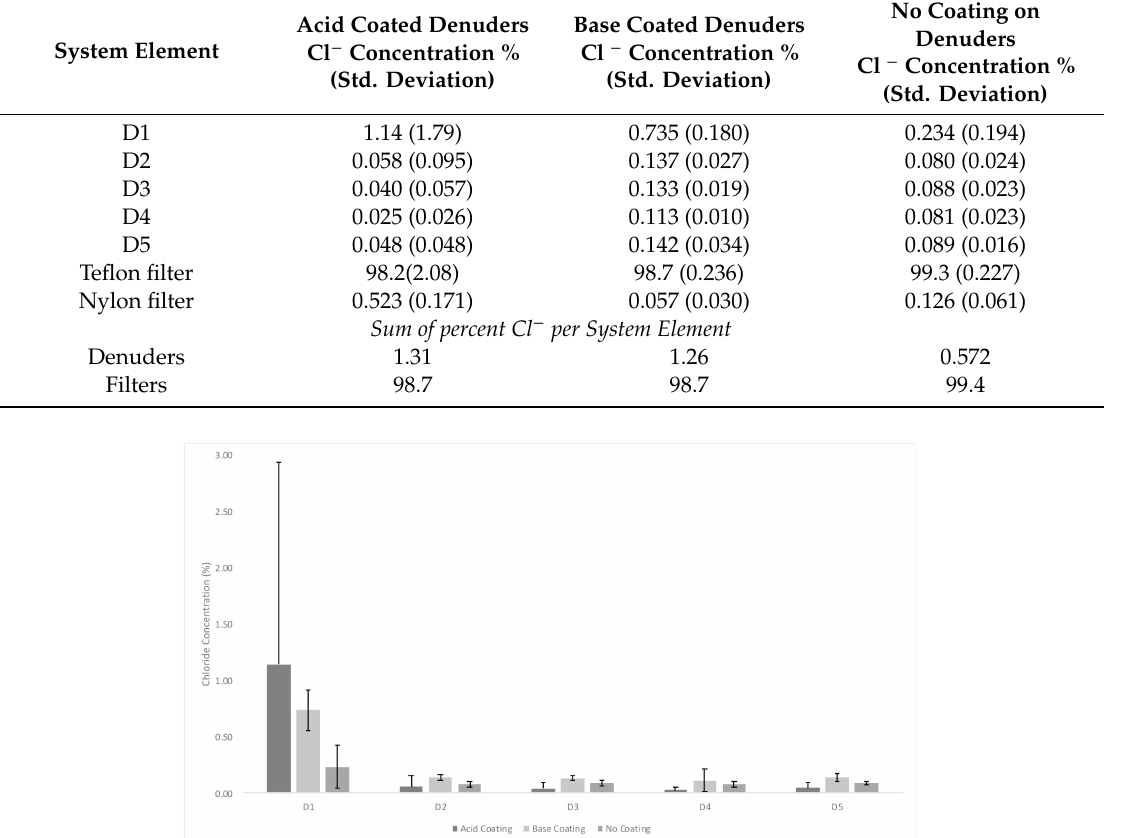
Table 3. Five Denuder Set-up–Percent Cl − Concentrations. The values are given as the average percentage of the three trials conducted per coating treatment type (acid, base, or no coating) for a total of nine trials. The standard deviation is presented in brackets for each of the three coating types.